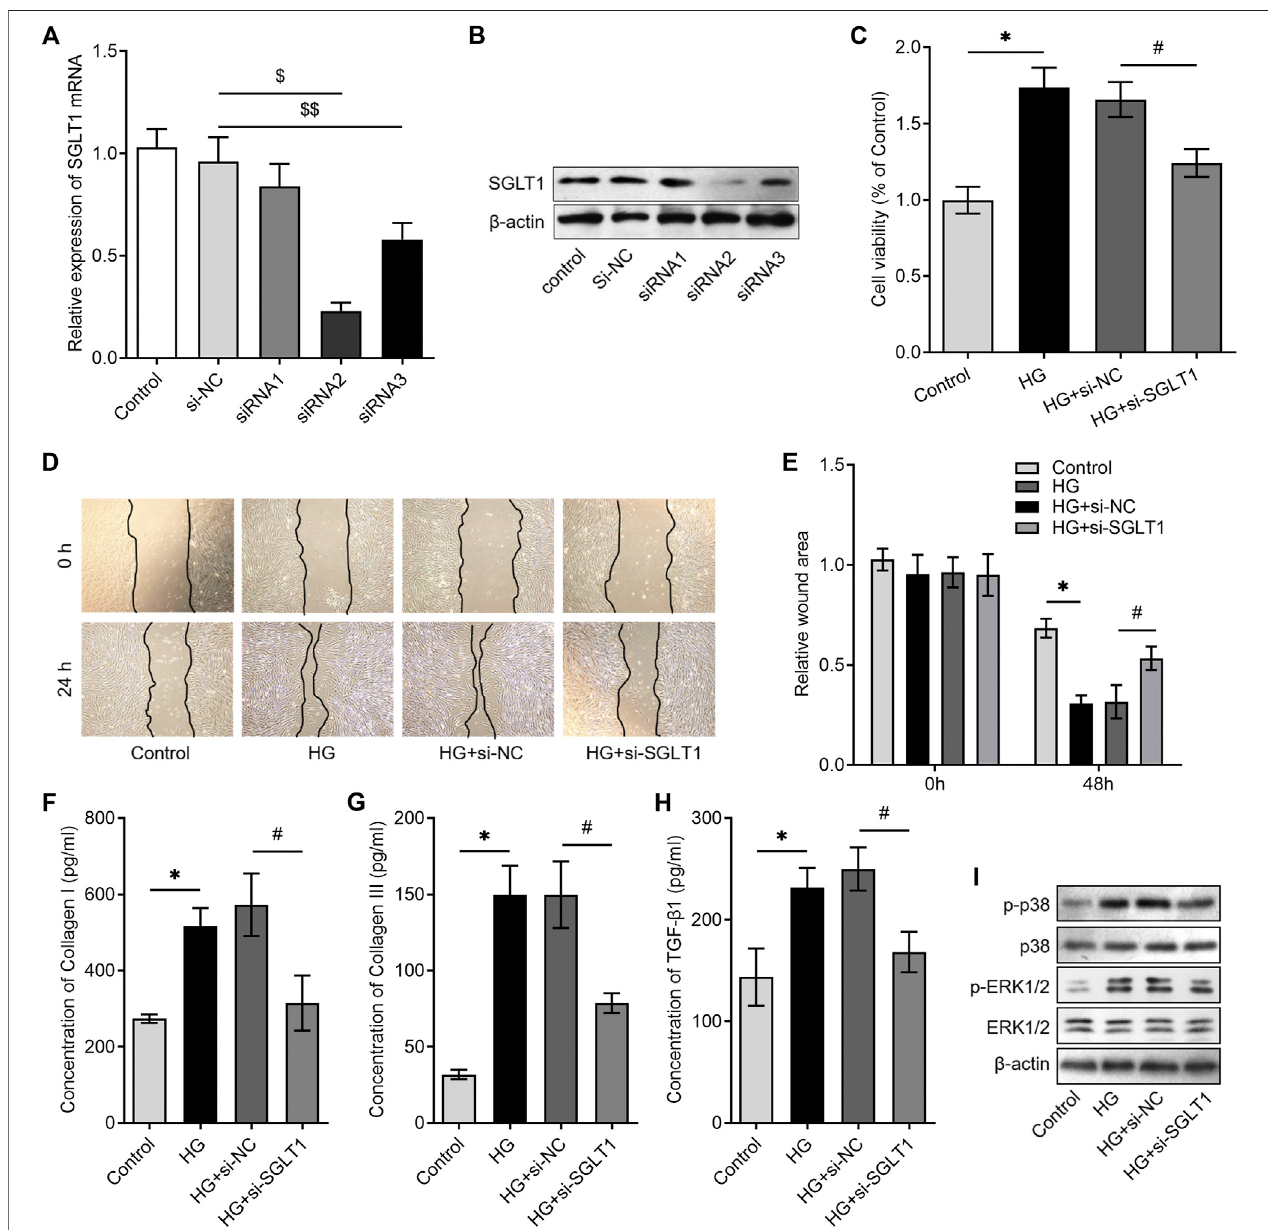
FIGURE3 | Knockdown ofSGLT1 inhibited high-glucose – induced CF activation. CFs were transfected with SGLT1 siRNAs, and SGLT1 mRNA and protein levels were detected using RT-qPCR (A) and western blotting, respectively (B) . CCK-8 assay was used to detect the proliferation of CFs under high-glucose condition with or withoutSGLT1inhibition. (D,E) Therepresentativeimages ofthewound-healingassaywereobtainedat0and 24 hafterknockdownofSGLT1,and themigrativeability of CFs was compared. (F – H) ELISA was used to detect the levels of collagen-synthesis – related markers, including TGF- β 1, collagen I, and collagen III in the cell supernatant ( n (cid:2) 6). (I) Western blotting analysis was performed to investigate the phosphorylation levels of p38 mitogen-activated protein kinase (MAPK) and extracellular signal-regulated kinase (ERK)1/2 in CFs under high-glucose condition with or without SGLT1 inhibition.